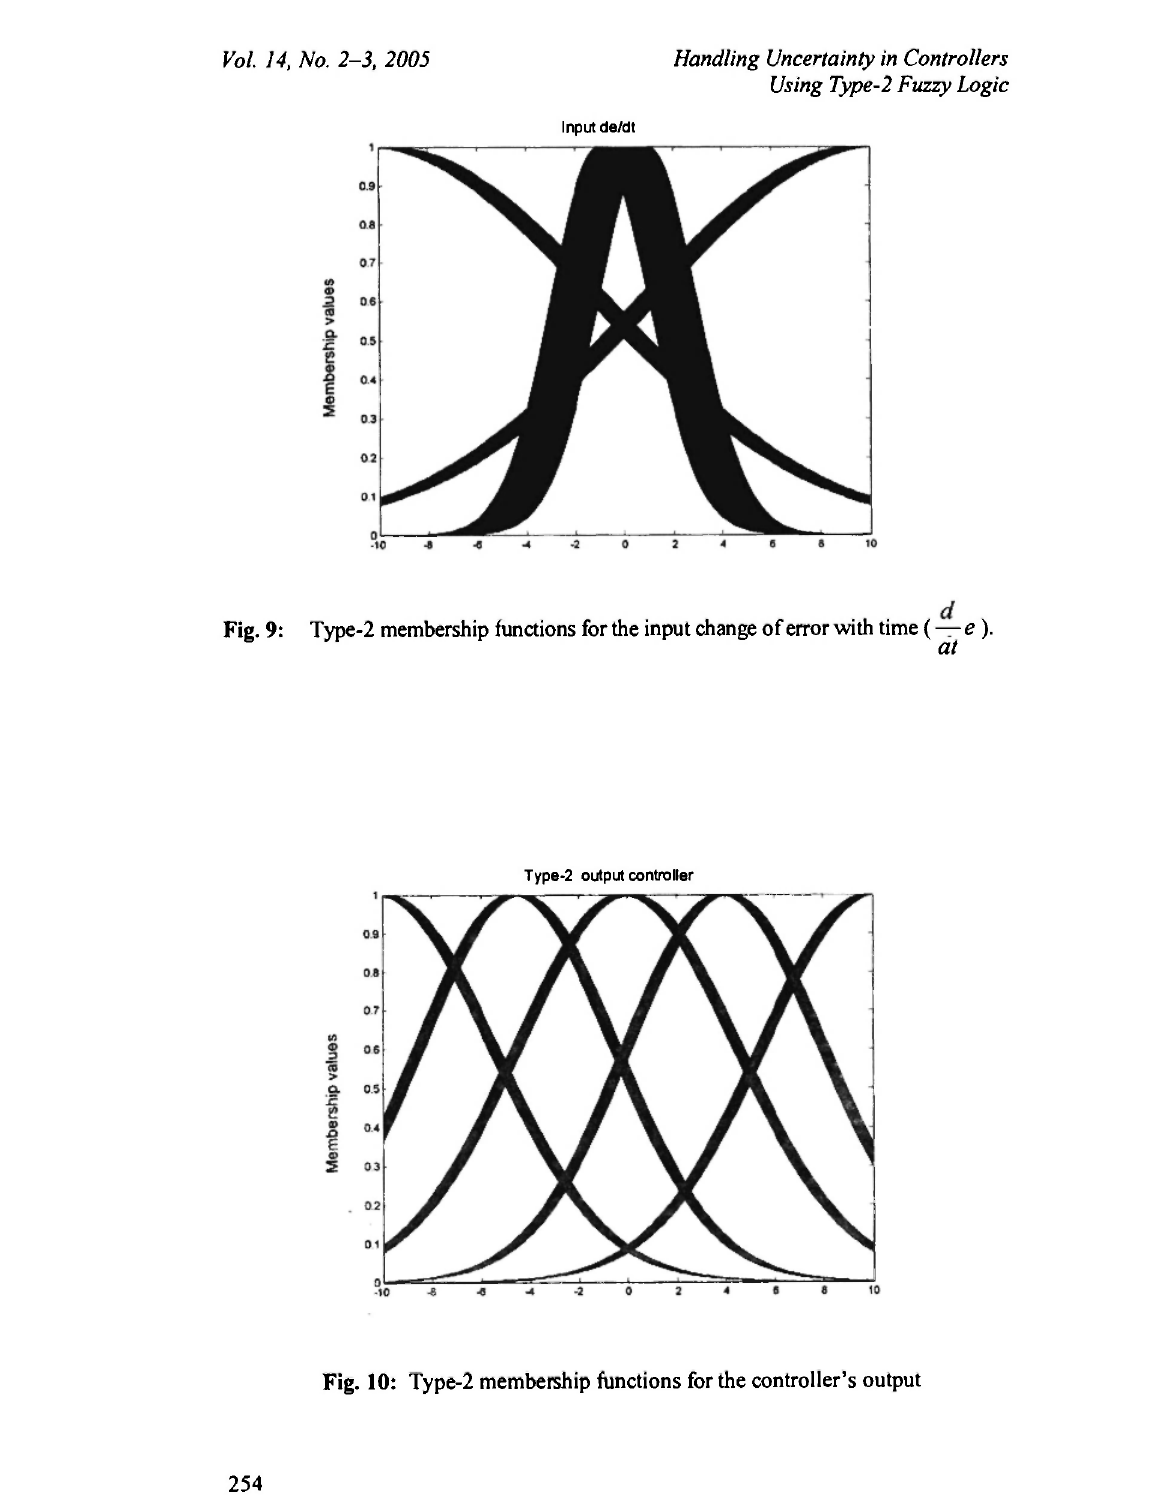
Fig. 10: Type-2 membership functions for the controller's